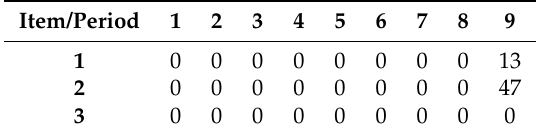
Table 5. Periodical shortage during the shifted planning horizon.